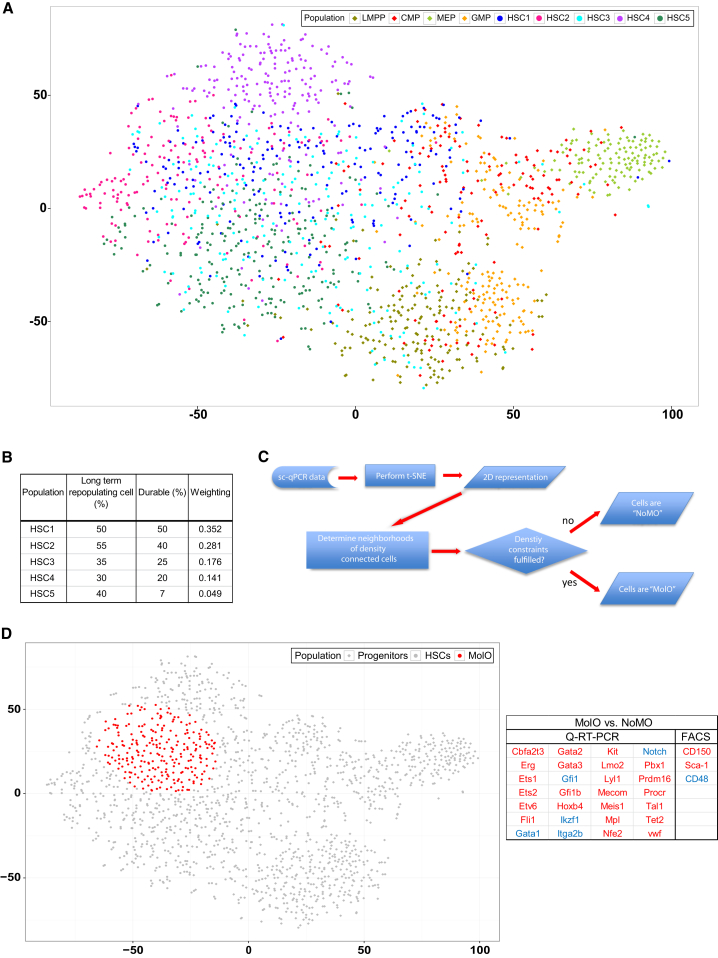
Multidimensional Analysis Can Further Resolve Cell Populations(A) t-SNE plot of all cells calculated from the 43 genes analyzed by Fluidigm. All HSCs are circles and all progenitors are diamonds. Axes are in arbitrary units.(B) Table of the published repopulation data used for the weighting program and schematic of the computational weighting program.(C) Schematic showing the definition of MolO cells.(D) t-SNE plot as in (A) with the MolO HSCs identified by the computational weighting highlighted in red. Axes are in arbitrary units. Table showing differentially regulated genes between MolO and NoMO populations. Red, genes upregulated in MolO population; blue, genes downregulated in MolO population.See also Figure S2.